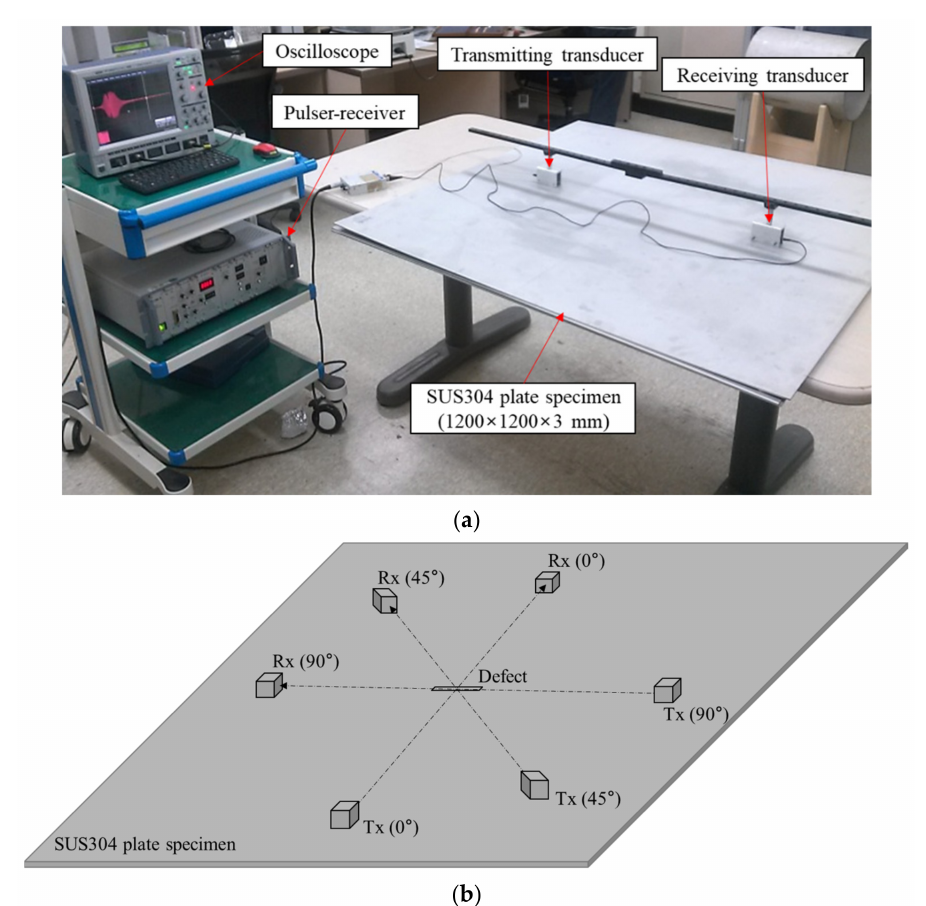
Figure 2. ( a ) Photograph of the experimental setup and ( b ) measuring angles between each ultrasonic transducer and a